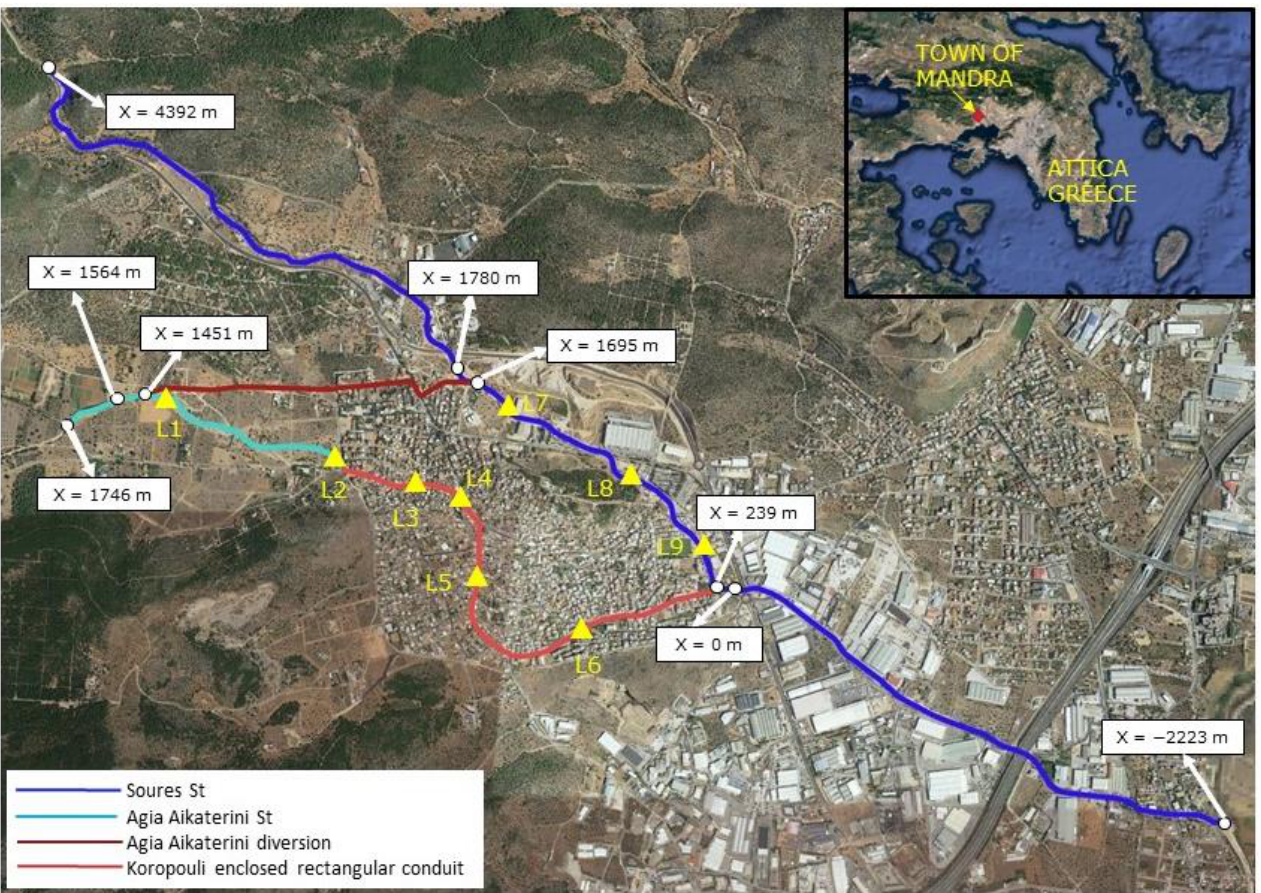
Figure 1. The area of study with the main streams and the flood protection works; the numbered small triangles denoted as L1 to L9 indicate the monitoring locations where flood arrival times are calculated.